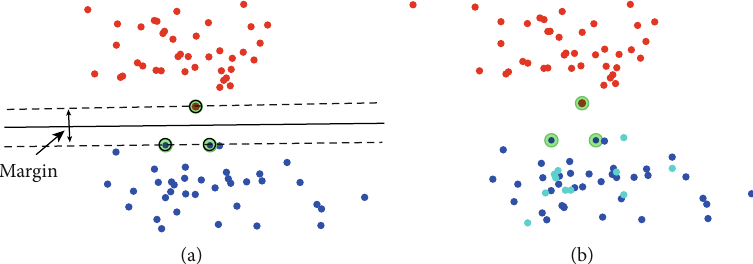
Figure 2: Toy problem with 100 data points for SVM. (a) 80-point training set and (b) 20-point test set superimposed onto training